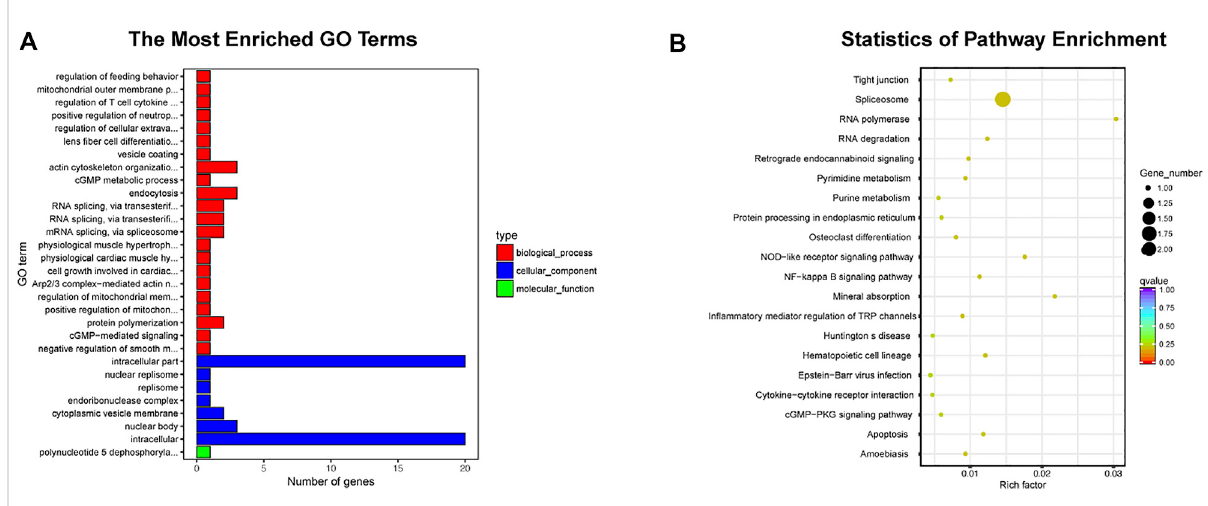
FIGURE 4 Enrichment analysis of exosome-derived miRNAs clearly related to TMJOA. (A) GO analysis, 30 enriched iterms are shown. (B) KEGG analysis, 20 pathways are